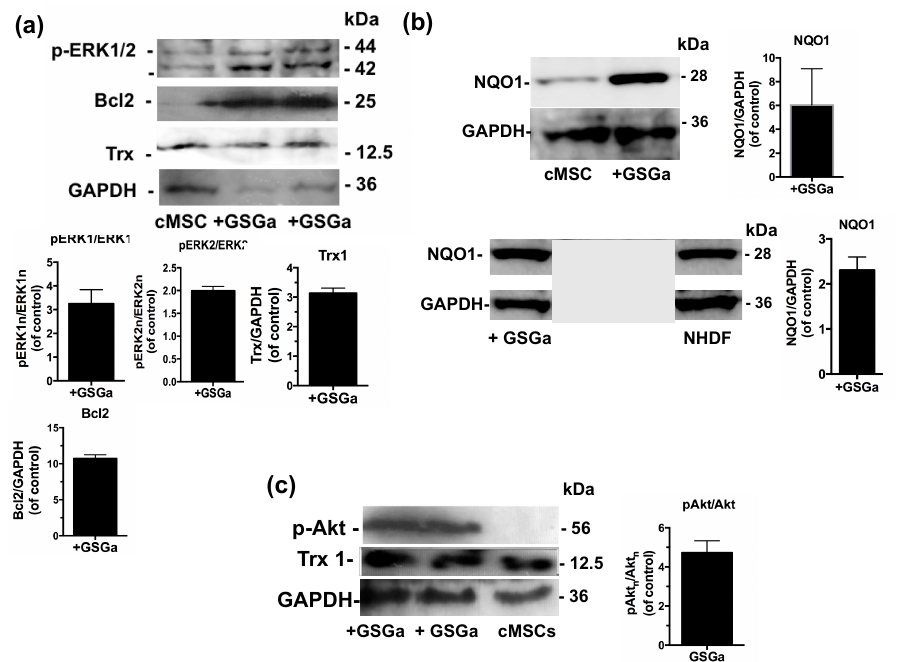
Figure 4. Effects of the GSGa on the protein expression. ( a ) Representative western blot analysis of the expression of p-ERK1/2, Bcl2, Trx1 and GAPDH in cMSC cultured for 3 days in the presence (+GSGa) or in the absence (cMSC) of 680 μ g/mL of GSGa; ( b ) Representative western blot analysis of the expression of NQO1, GAPDH in both cMSCs and NHDFs cultured for 3 days in the presence (+GSGa) or in the absence (MSC or NHDF) of 680 μ g/mL of GSGa, The integral figure of the NHDFs blot and the original western blot of MSC for NQO1 expression are shown in the Supplementary Materials (Figures S9 and S10); ( c ) Representative western blot analysis of the expression of p(Ser 473)Akt in cMSC after 3 days of treatment with (+GSGa) or without (cMSC) GSGa, GAPDH expression was used as normalization control. Error bar indicates s.e.m or S.D.. Experiments were performed in three or five biological replicas (one-tailed Student’s t-test).